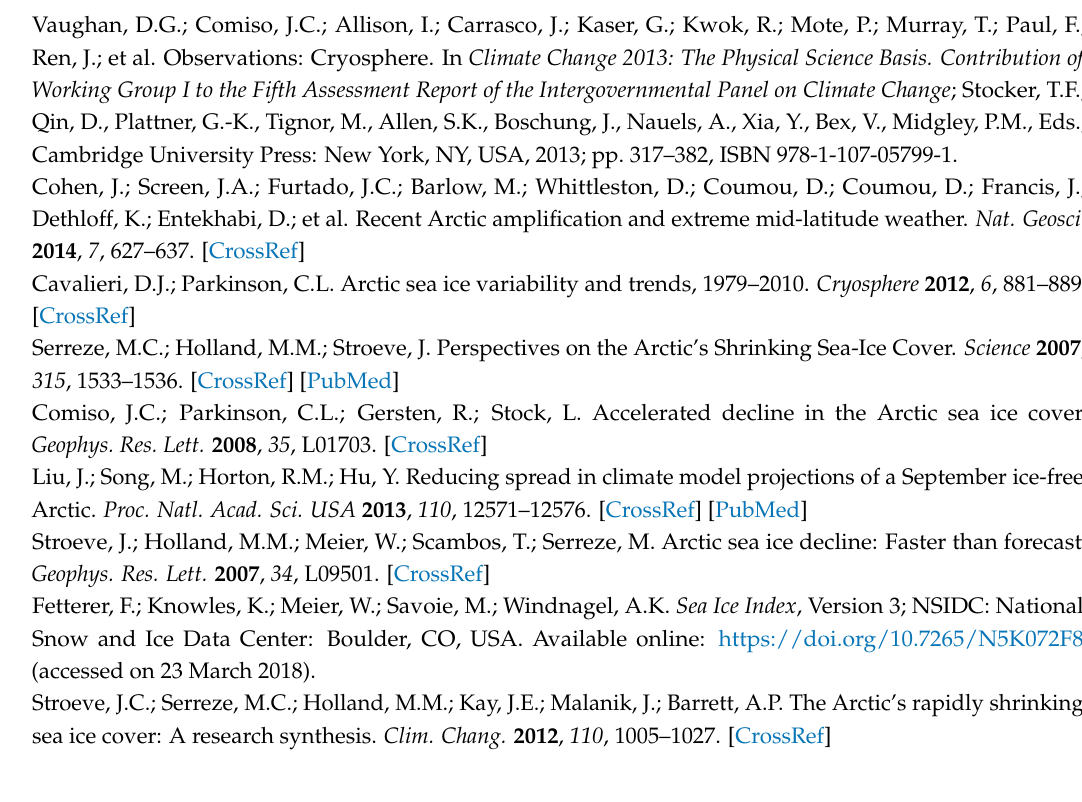
Correlation maps of downward surface longwave radiation flux at the lead time of 1–4 months with the September Arctic SIE, Figure S4: Correlation maps of net surface longwave radiation flux at the lead time of 1–4 months with the September Arctic SIE, Figure S5: Correlation maps of SST at the lead time of 1–4 months with the September Arctic SIE, Figure S6: Correlation maps of sea-level pressure at the lead time of 1–4 months with the September Arctic SIE, Figure S7: Correlation maps of zonal component of wind at 10-m height at the lead of 1–4 months with the September Arctic SIE, Figure S8: Correlation maps of meridional component of wind at 10-m height at the lead time of 1–4 months with the September Arctic SIE, Figure S9: Climatology mean of September Arctic SIC over